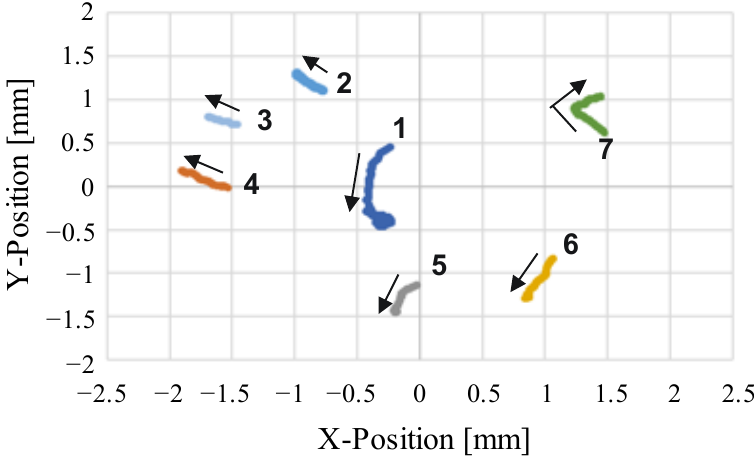
Figure 8. Changes in the positions of the droplets over